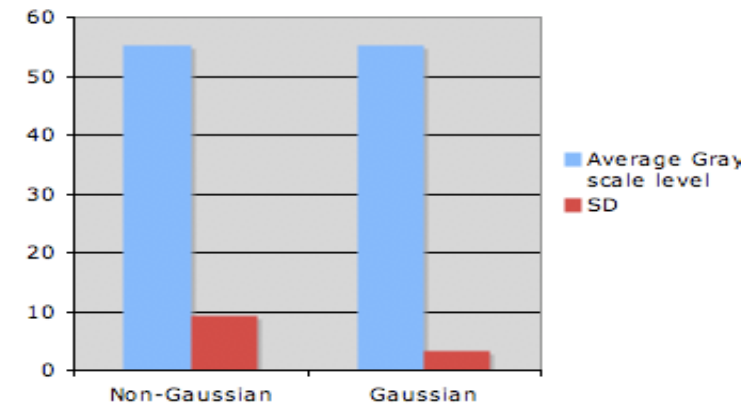
Figure 4. The effect of Gaussian filtration — The Gaussian filter did not alter the average gray scale level significantly in the reconstructed µCT images of Ti implant in bone, however, there is a vast improvement in the signal-to-noise ratio (standard deviation).